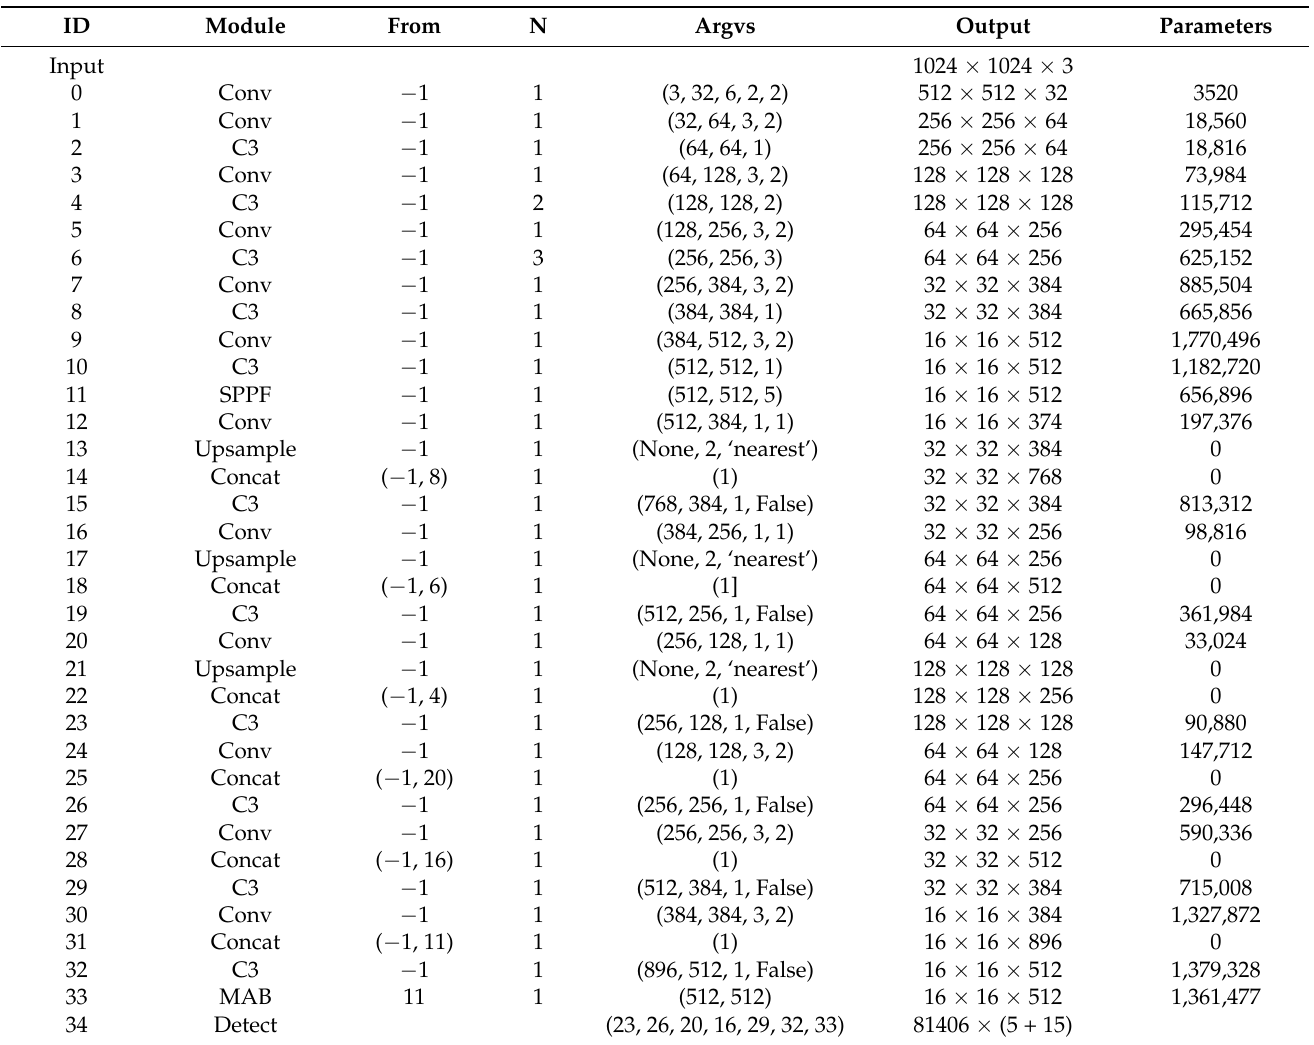
Table 2. Parameter setting of the network